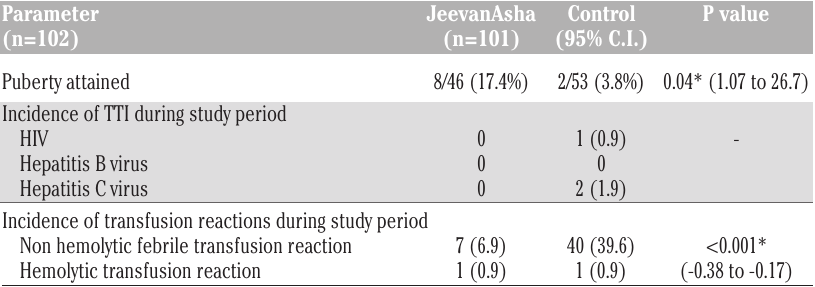
Table 3. Table showing attainment of puberty, incidence of transfusion transmitted infec- tions, and incidence of transfusion reactions in both study arms.